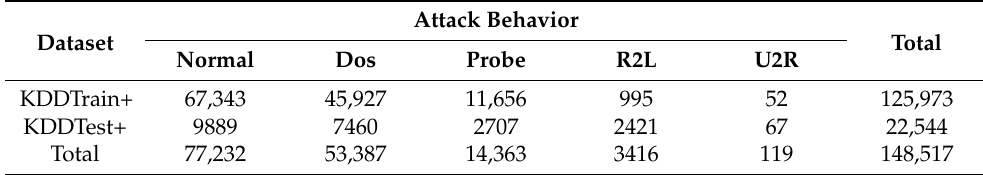
Table 3. Distribution of different attack behaviors in the NSL-KDD